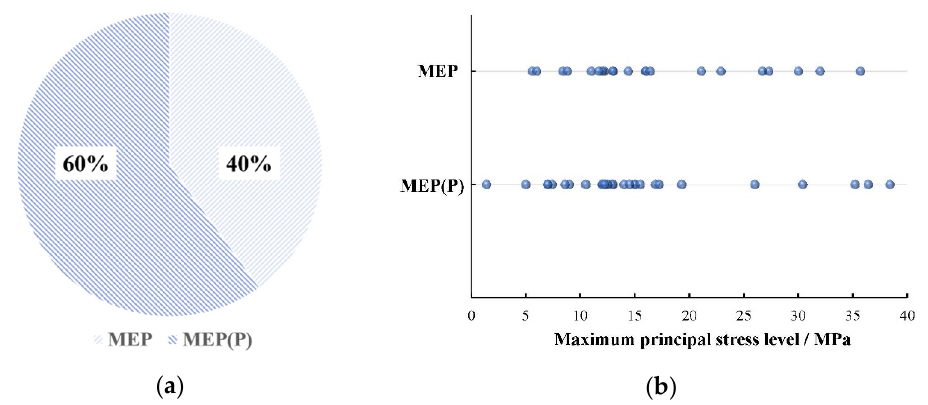
Figure 14. Statistics of excavation procedures at the rock anchor beam zone. ( a ) The usage proportion of excavation procedures. ( b ) In situ stress distribution of excavation procedures